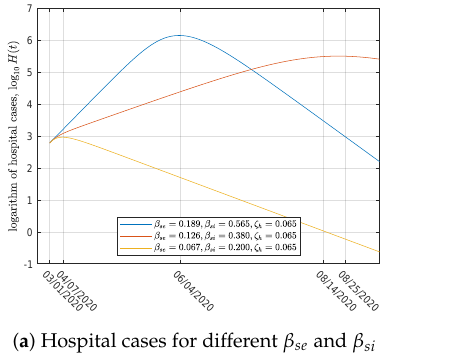
Figure 6. Simulation results using different